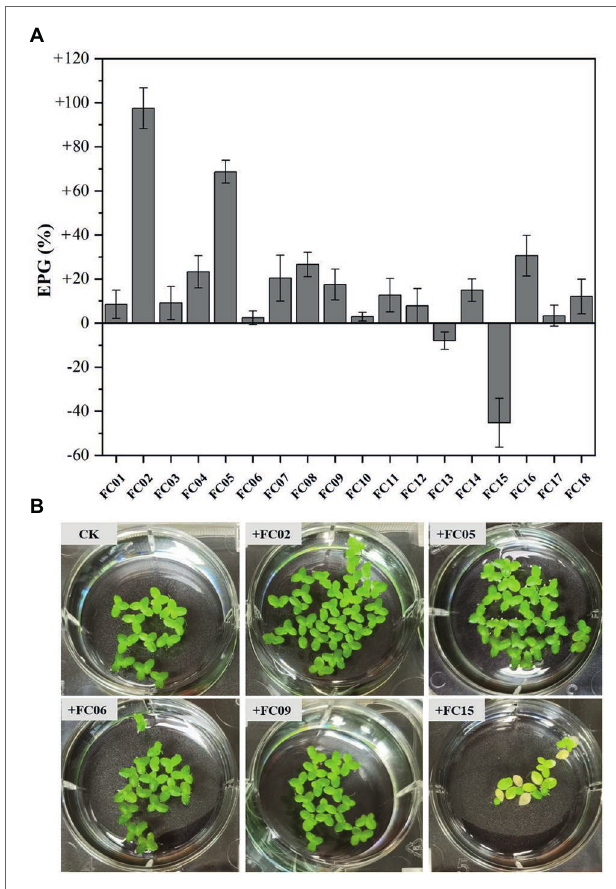
FIGURE 2 | Effects on plant growth (EPG) of single isolated bacteria on plant growth (A) . EPG was evaluated by the change in fresh weight of Lemna aequinoctialis relative to that of aseptic control. Error bars show the standard errors ( n = 3). Photograph images of duckweed inoculated with several strains after 7 days (B)